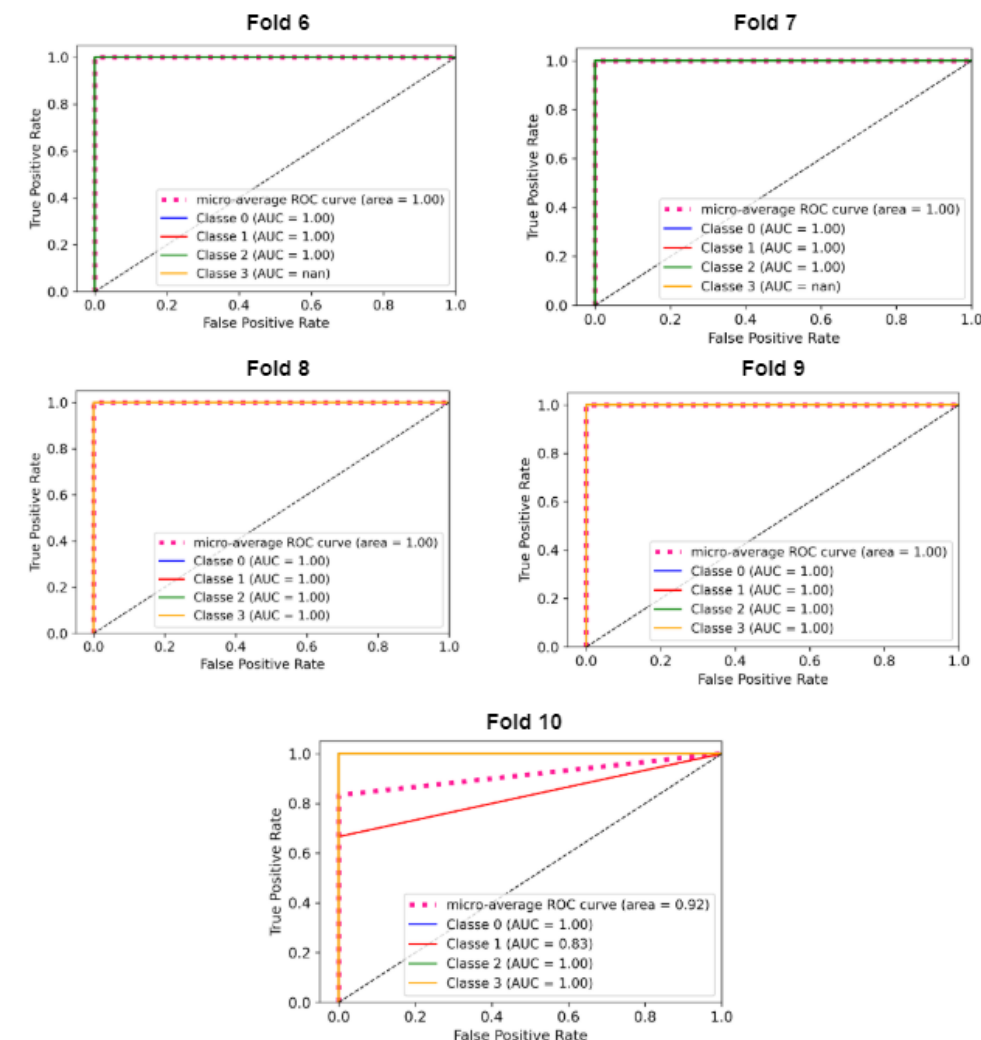
Figure 4. ROC curves of the DT model using SMOTE and the nested CV method for the sixth, seventh, eighth, ninth, and tenth folds. Each graphic represents one of the ten